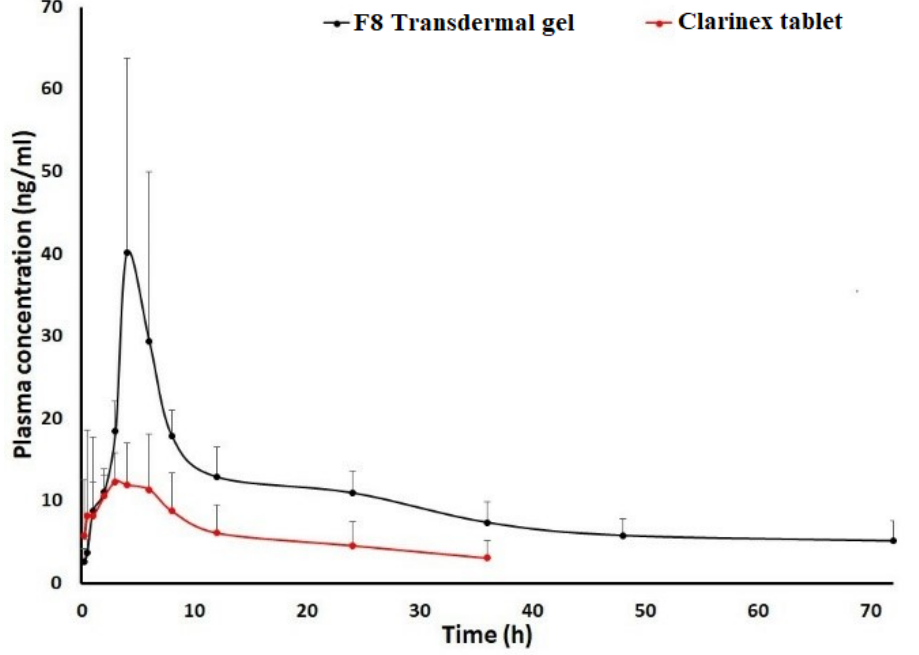
Figure 8. Pharmacokinetic profiles of F8 transdermal gel and Clarinex tablet formulations in New Zealand white rabbits. Data are shown as mean ± SD, n = 4.